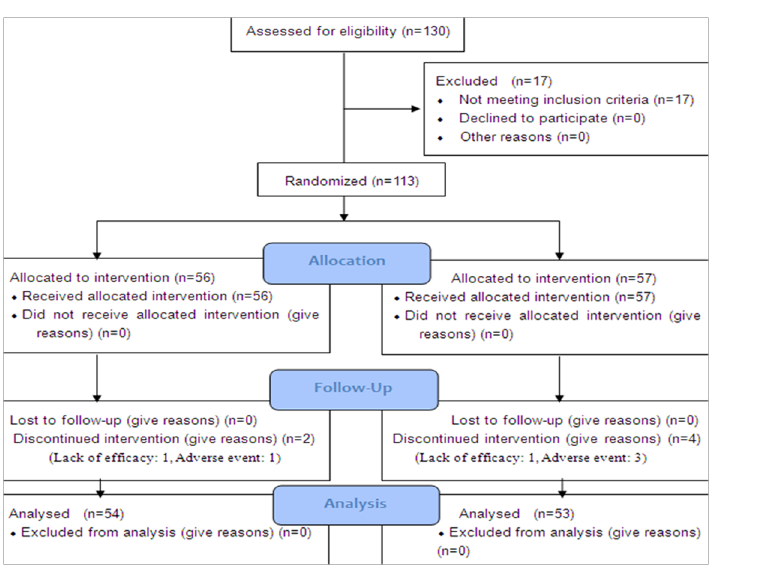
contrast analysis showed that BMIs or plasma levels of low density lipoproteins were signifi- cantly lower in the aripiprazole group compared with the control group after taking into account baseline values at week 8 ( t = 5.189, P = 0.023 or t = 4.30, P = 0.038, respectively) (Fig 3). There were no significant differences in changes of Fasting Plasma Glucose, Total cholesterol, Triglycerides and High Density Lipoprotein within each group at week 4 and 8 (Table 2).